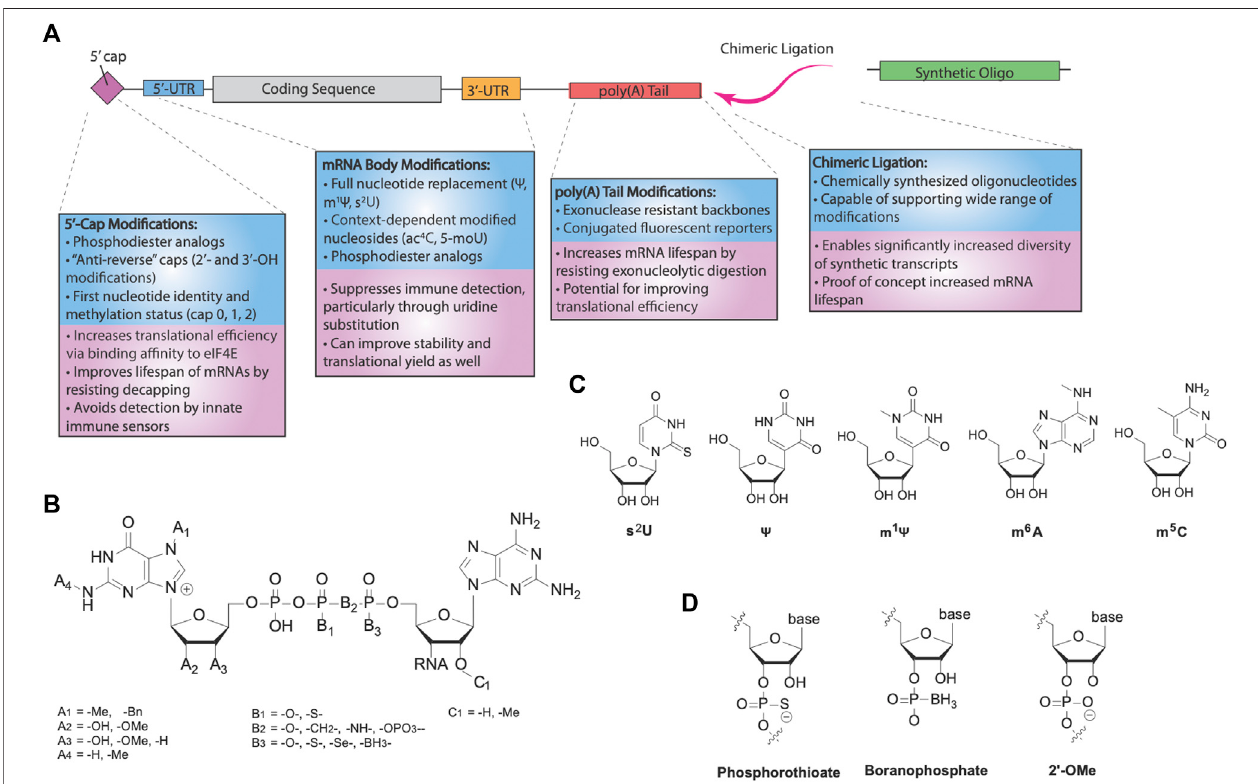
FIGURE 2 | RNA modi fi cations for mRNA therapeutics. (A) Categories of different modi fi cations for mRNA. Modi fi cation of the cap and nucleotide substitution of the mRNA body are important for innate immune avoidance. Translational ef fi ciency and mRNA stability are further modulated by various modi fi cations, via increased eIF4E binding and reduced hydrolysis by nucleases. Additionally, chimeric ligation is a separate class of modi fi cation enabling incorporation of highly modi fi ed synthetic oligonucleotides,formingchimericmocRNAs. (B) Chemicalstructureof5 ′ -caps.Eukaryoticcapsaretypicallymodi fi edonthe fi rstbase(A ’ s),triphosphate (B ’ s),or second base (C ’ s). (C) Common modi fi ed bases used for modi fi cation of mRNA. 2-thiouridine (s 2 U), pseudouridine ( Ψ ), and N 1 -methylpseudouridine (m 1 Ψ ) are uridine substitutes, whereas N6-methyladenosine (m 6 A) is an adenosine substituent and 5-methylcytosine (m 5 C) is a cytosine substituent. (D) Common backbone modi fi cations used for modi fi cation of mRNA. The phosphate backbone and 2 ′ -OH are frequently modi fi ed.